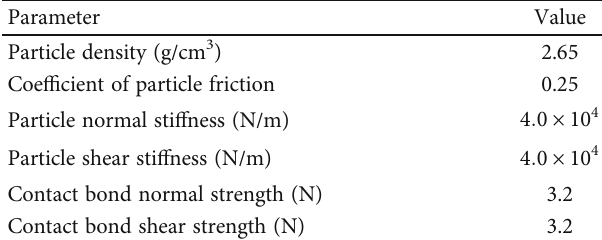
Table 2: Microscopic properties of soil particles in the top